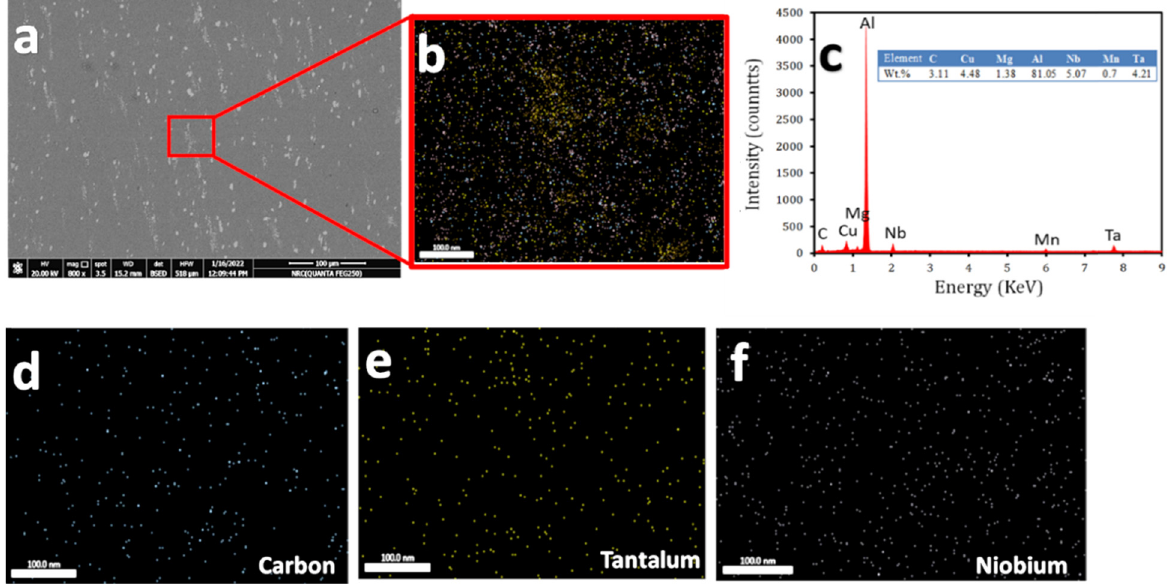
Figure 7: SEM images of the ( a ) AA2024/TaC_NbC hybrid nanocomposite and ( b ) its elemental map. ( c ) EDS analysis and element intensity. Elemental maps of ( d ) carbon, ( e ) tantalum, and ( f ) niobium.